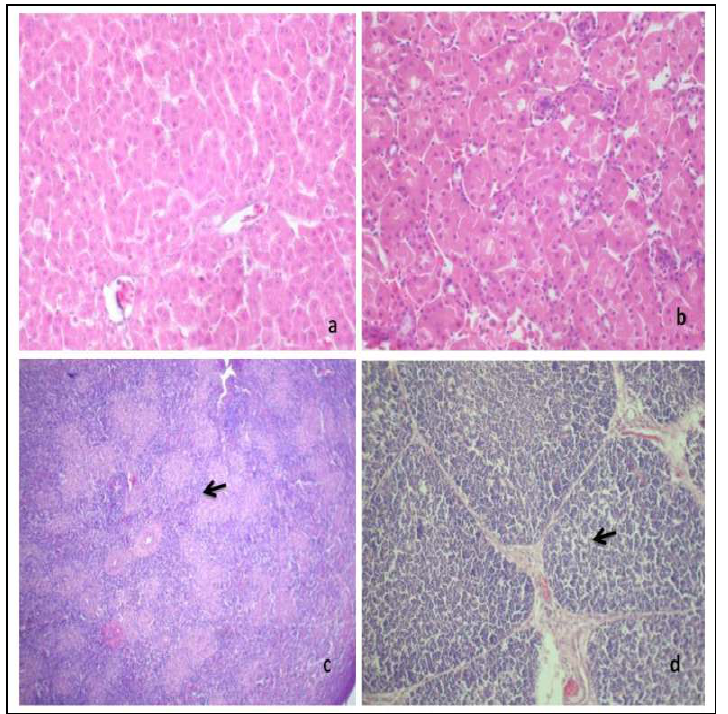
Figure-2. Photomicrographs of liver, kidney, spleen and